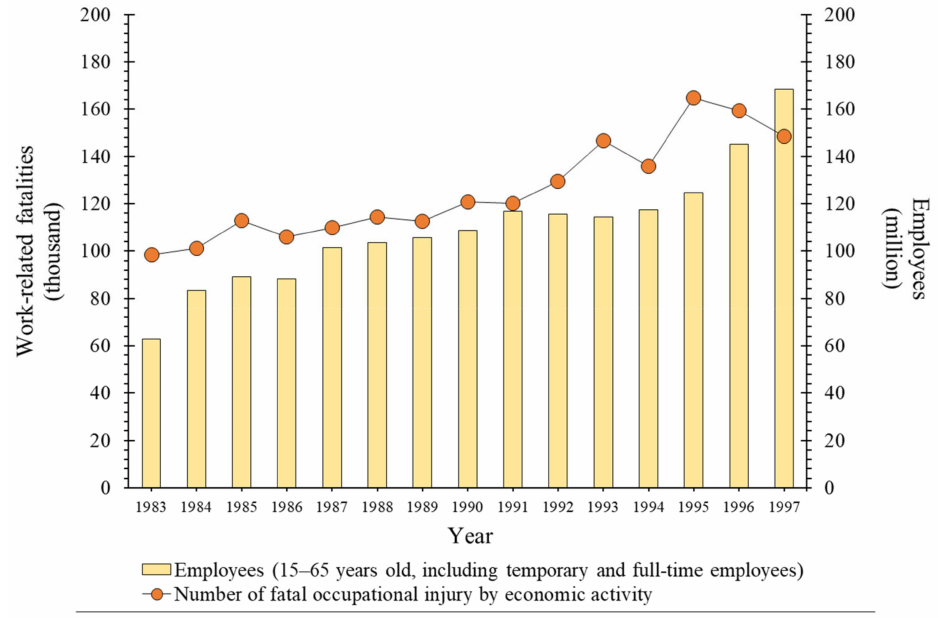
Figure 1. Number of employees and work-related fatalities worldwide at the end of the 19th century (data of 127 countries, including South Korea, Japan, Germany, and the United Kingdom, provided by the International Labour Organization